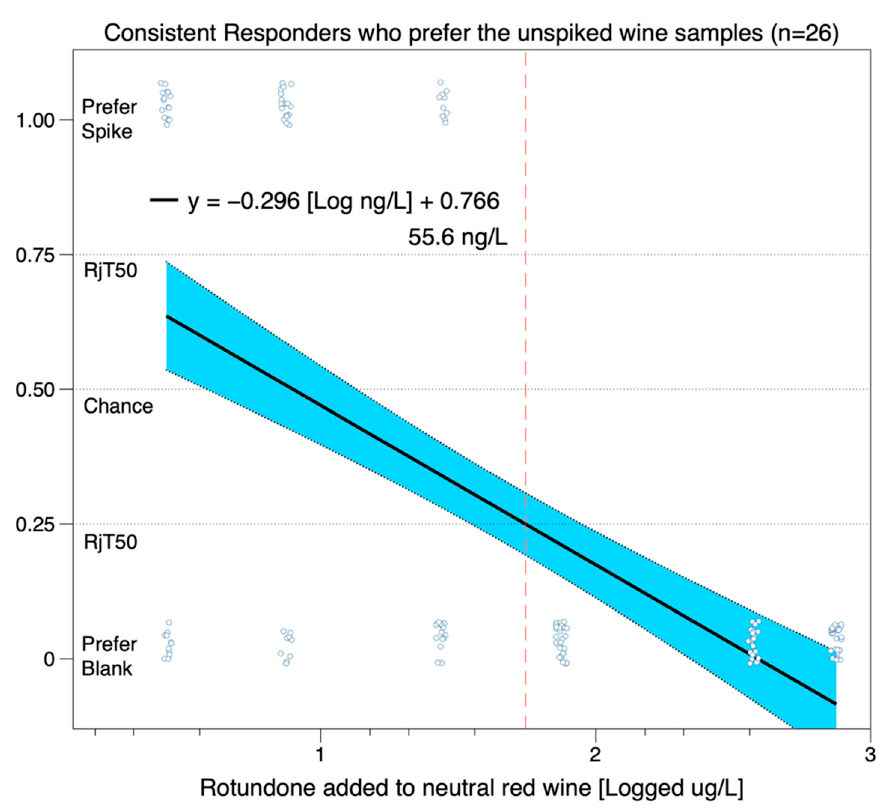
Figure 4. Estimated rejection threshold for consistent participants, after removing the 8 consistent participants who preferred the rotundone-containing wines.